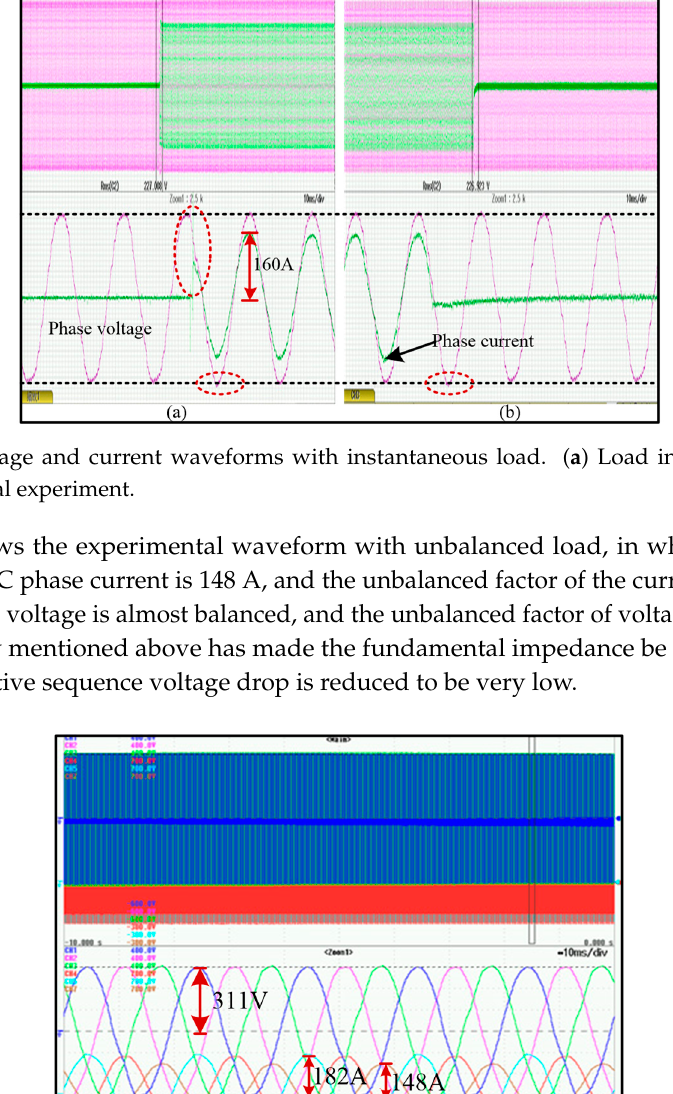
Figure 16. Voltage and current waveforms with unbalanced load.